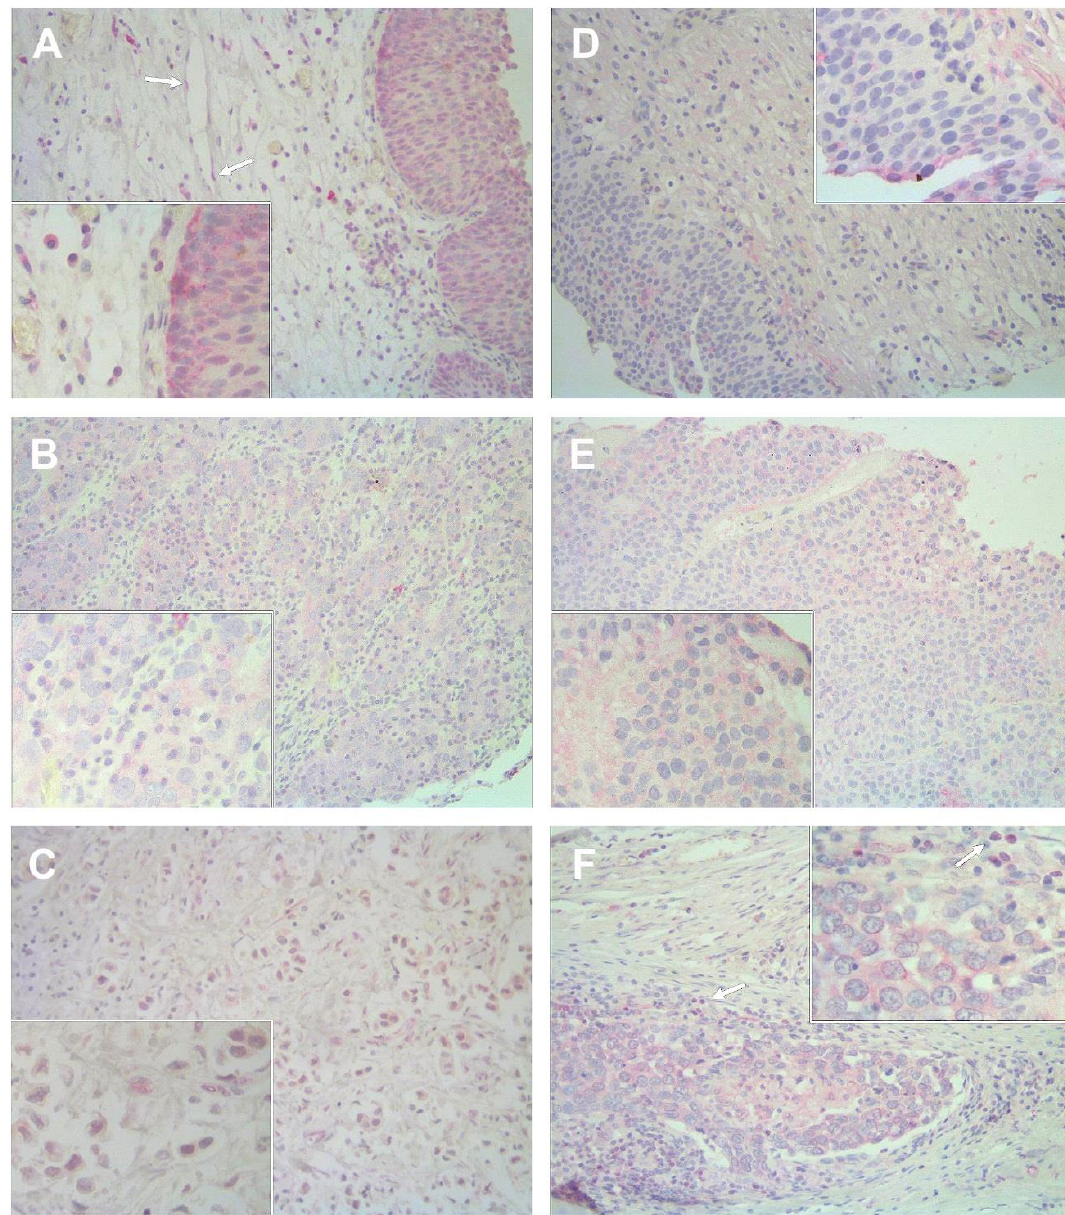
Figure 1. Immunohistochemical staining of AGO1 and AGO2 in bladder tissue. Representative images show the expression of AGO1 in non-malignant bladder tissue ( A ), in non-muscle-invasive pT1 tumor ( B ) and muscle-invasive pT3b tumor tissue ( C ); as well as the expression of AGO2 in normal bladder tissue ( D ), in non-muscle-invasive pTa tumor ( E ) and muscle-invasive pT3b tumor tissue ( F ). The arrows indicate the staining in endothelial cells ( A ) and AGO2 staining of lymphocytes ( F ). Pseudoluminal expression of AGO2 can be seen in ( D ). Magnification: 200×, inserts 400×.